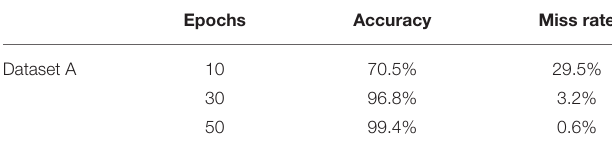
TABLE 5 | Training model on dataset A.